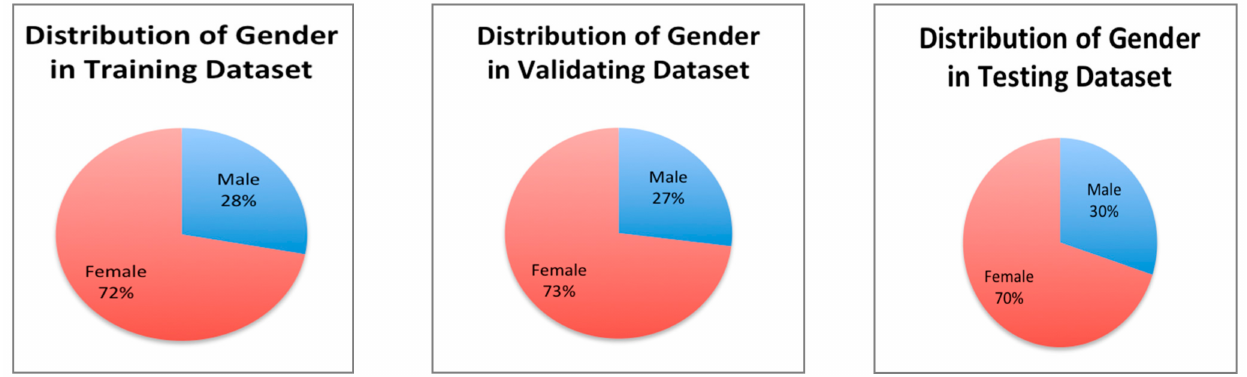
Figure 4. Distribution of gender in the SiW